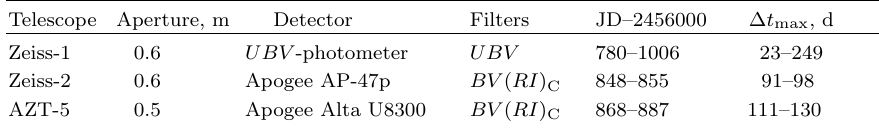
Table 1. Photometric observations.